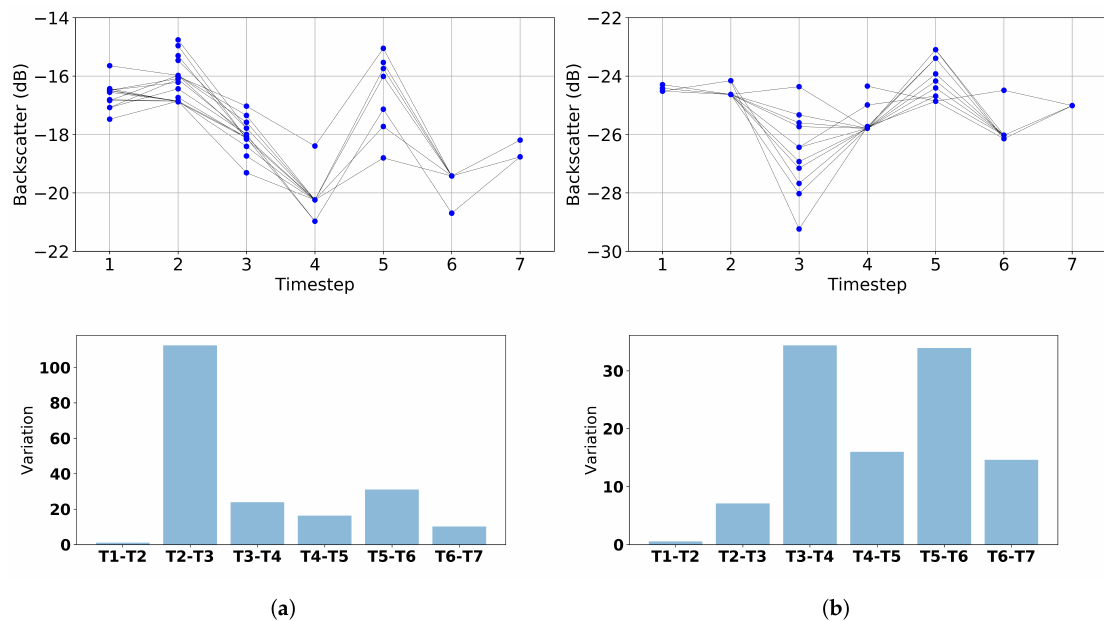
Figure 15. Temporal profile and variation VV versus VH polarisation for descending SITS in the static zone. ( a ) Descending VV. ( b ) Descending